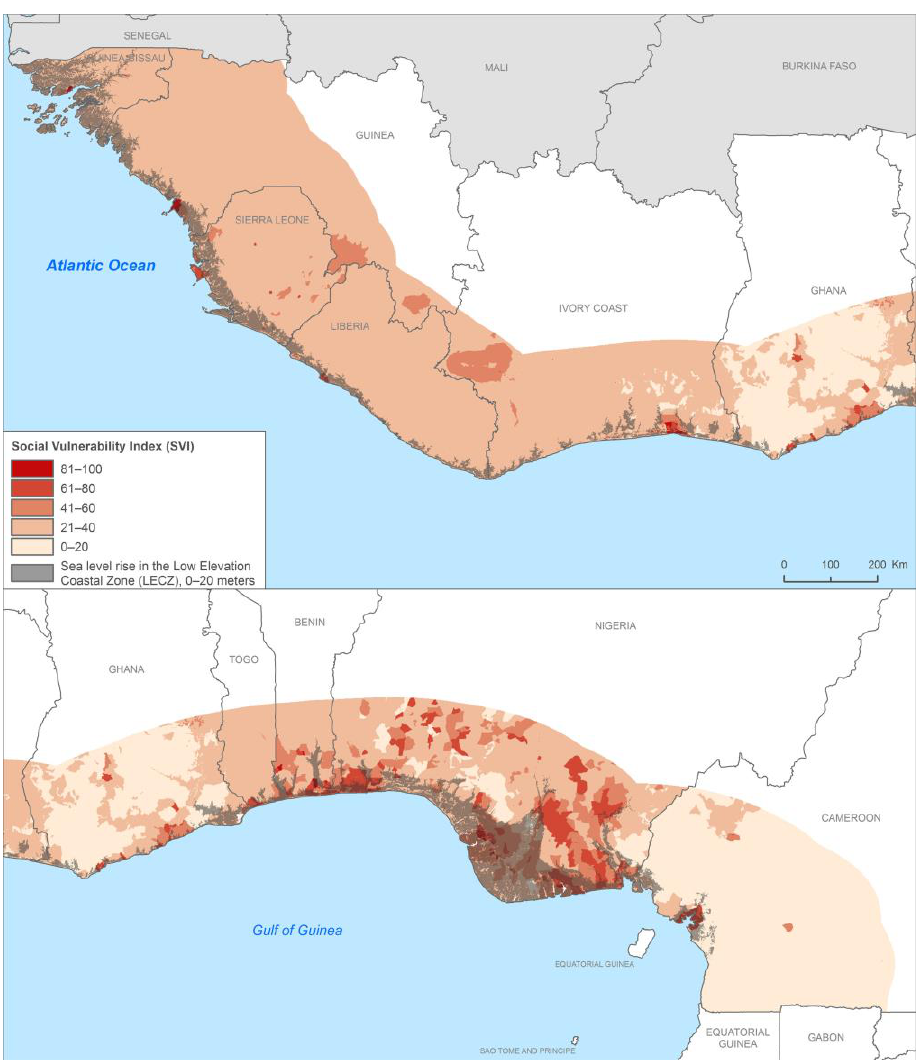
Figure 11. SVI in relation to the West Africa